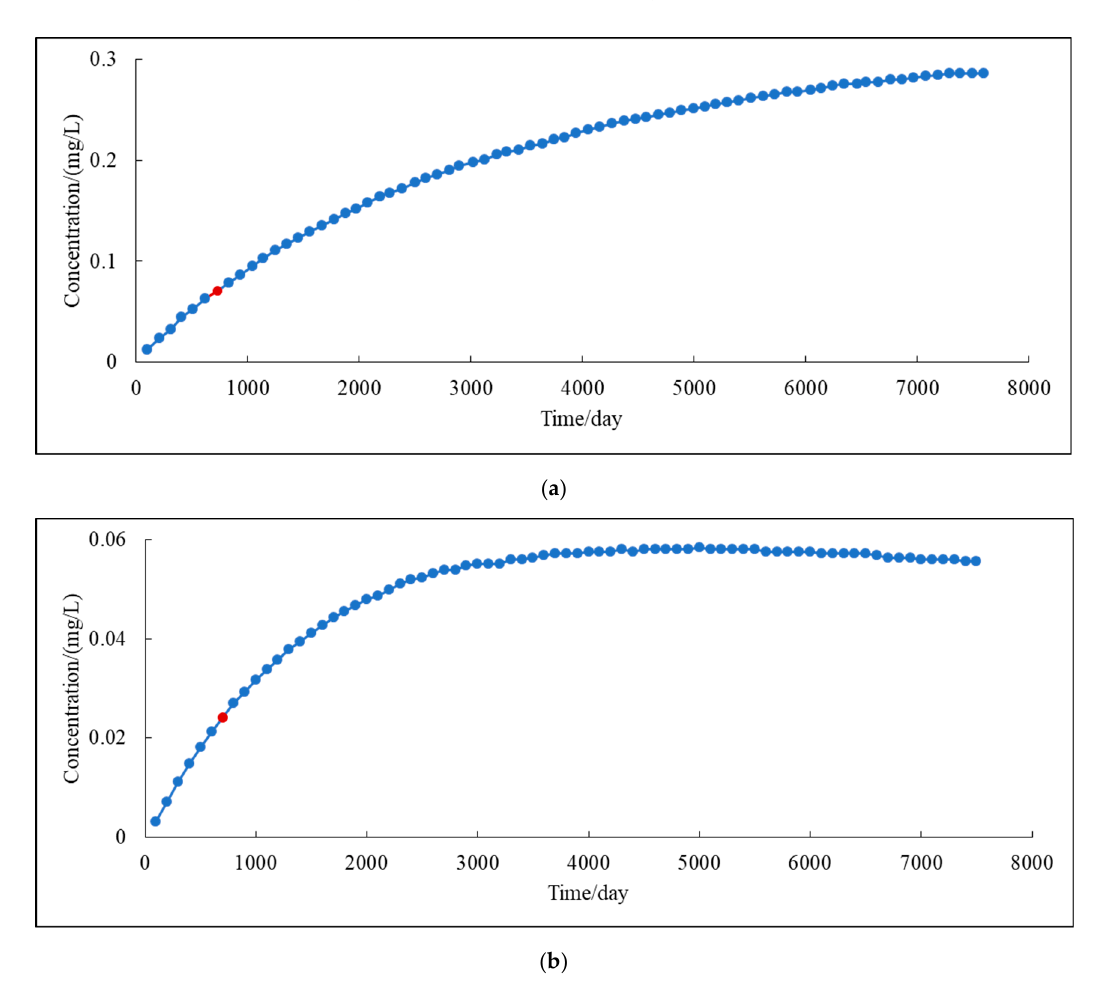
Figure 14. Changes in the ammonia content near wells. ( a ) Changes in ammonia content near well A. ( b ) Changes in ammonia content near well B.